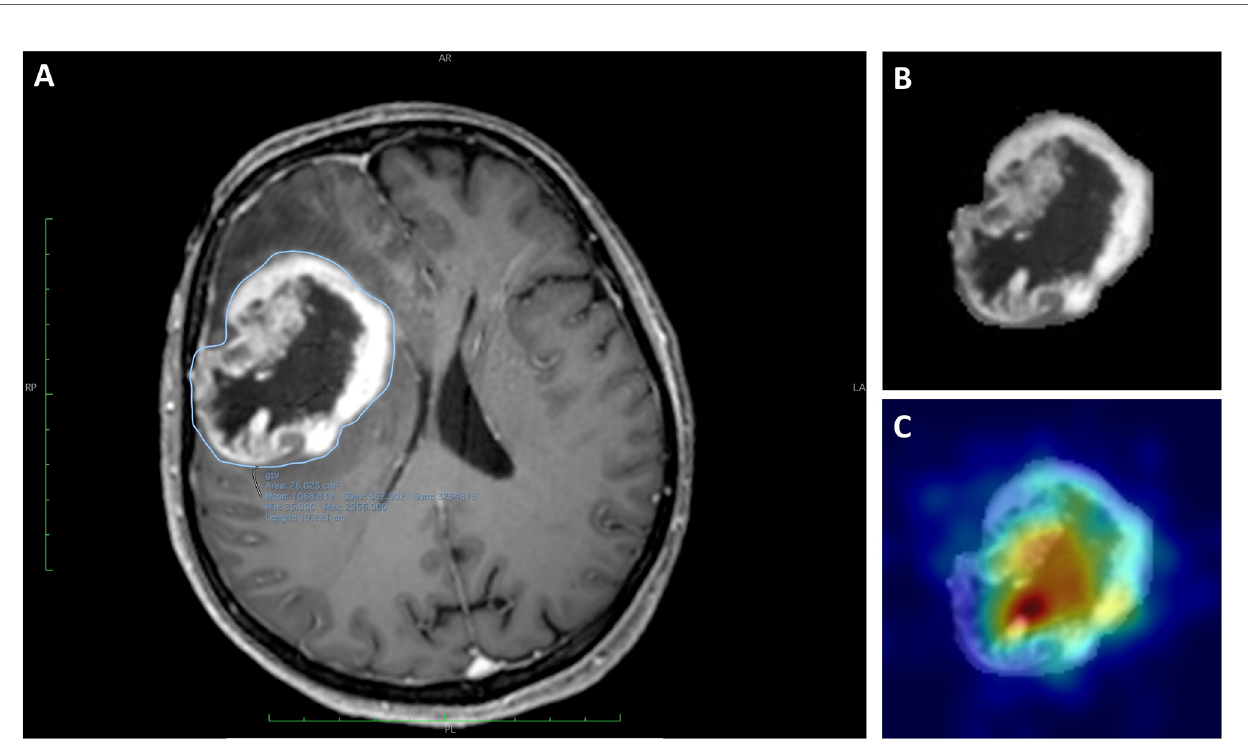
FIGURE 2 | Images of a 59-year-old woman with a histologically diagnosed GBM. (A) CE T1WI with the segmented region of interest (ROI). (B) Extracted ROI of the segmented lesion. (C) Extracted ROI and the corresponding gradient-weighted class activation map (Grad-CAM) showing the salient tumor regions identi fi ed by Resnet-10 and on which the DNN model relies to make its